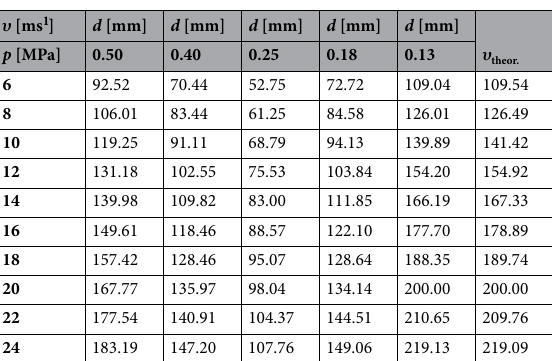
Table 1. Experimental results of cross-section speed v for given input pressures p with maximum uncertainty u v = 2.0 ms −1 and their comparison to theoretical values v theor without energy losses caused by contraction and friction.